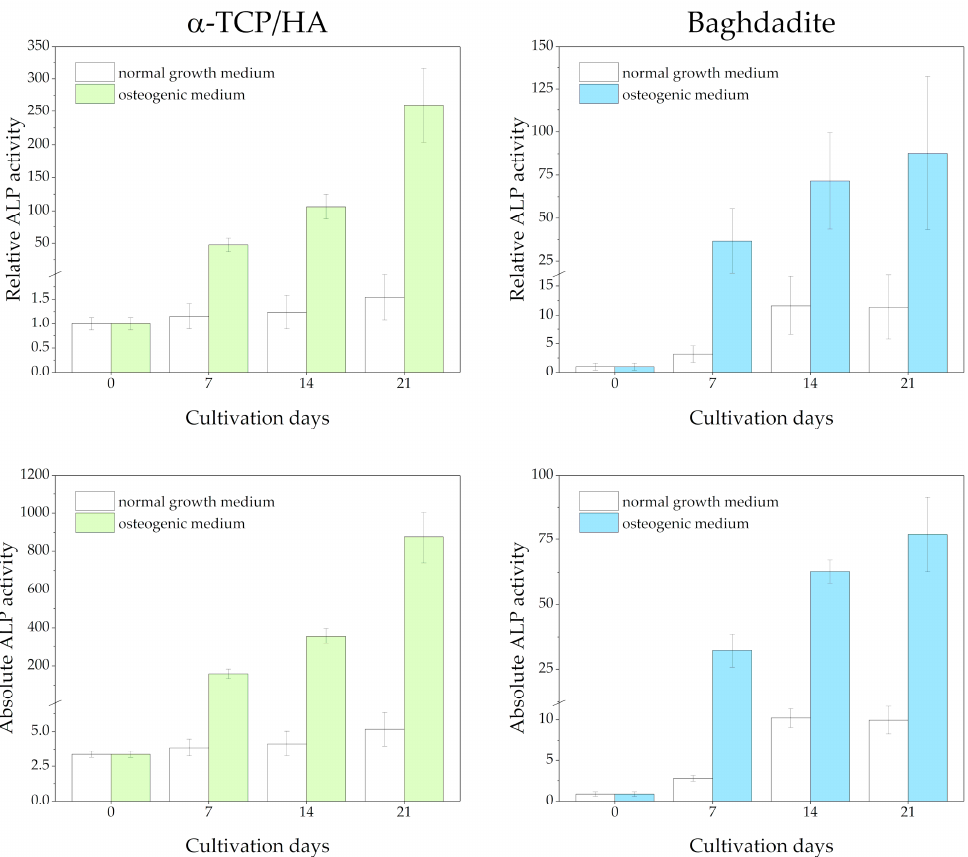
Figure 6. ALP activity of MC3T3-E1 cells seeded in α -TCP/HA and baghdadite scaffolds. The scaffolds were initially cultivated in normal growth medium for four weeks before transferal to osteogenic medium (colored bars) or continued to be cultured in normal growth medium (references, white bars). Three replicate experiments were performed for each time